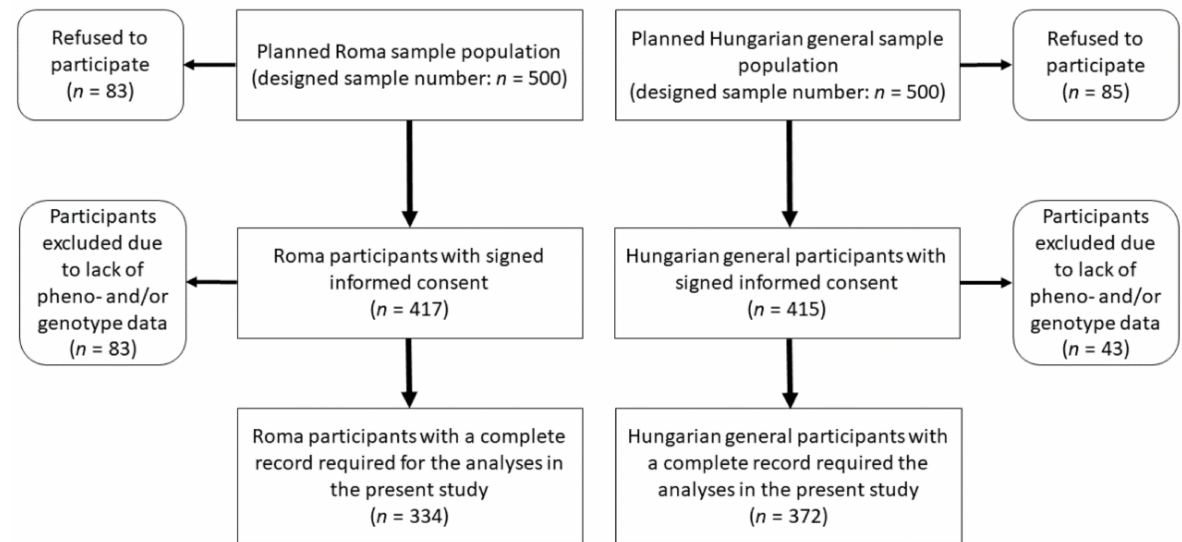
Figure 1. Flowchart showing the process of sample selection for Roma and Hungarian gen- eral